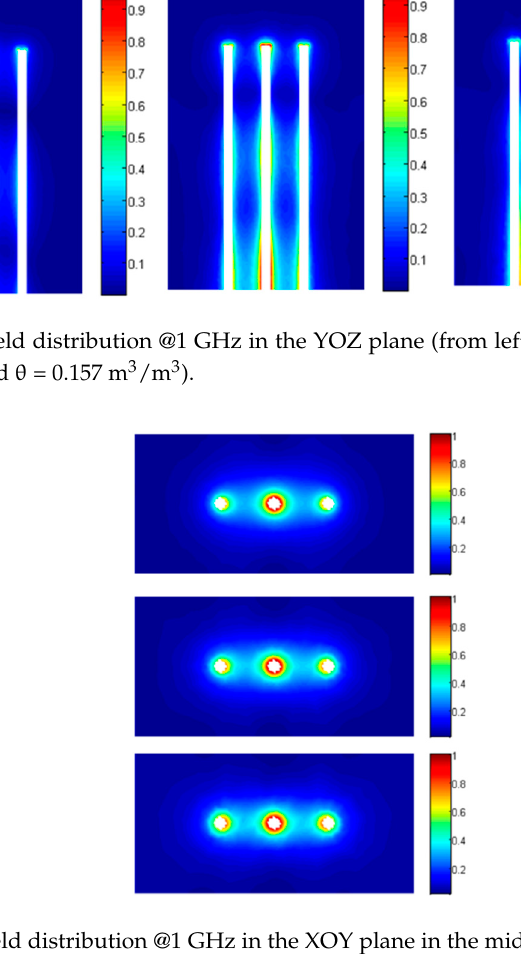
( b ) Figure 8. Magnitude of scattering function S 11 ( ω ) ( a ), corresponding TDR waveform ( b ) for the probe surrounded by air and clay rock ( θ = 0.022 m 3 /m 3 ).